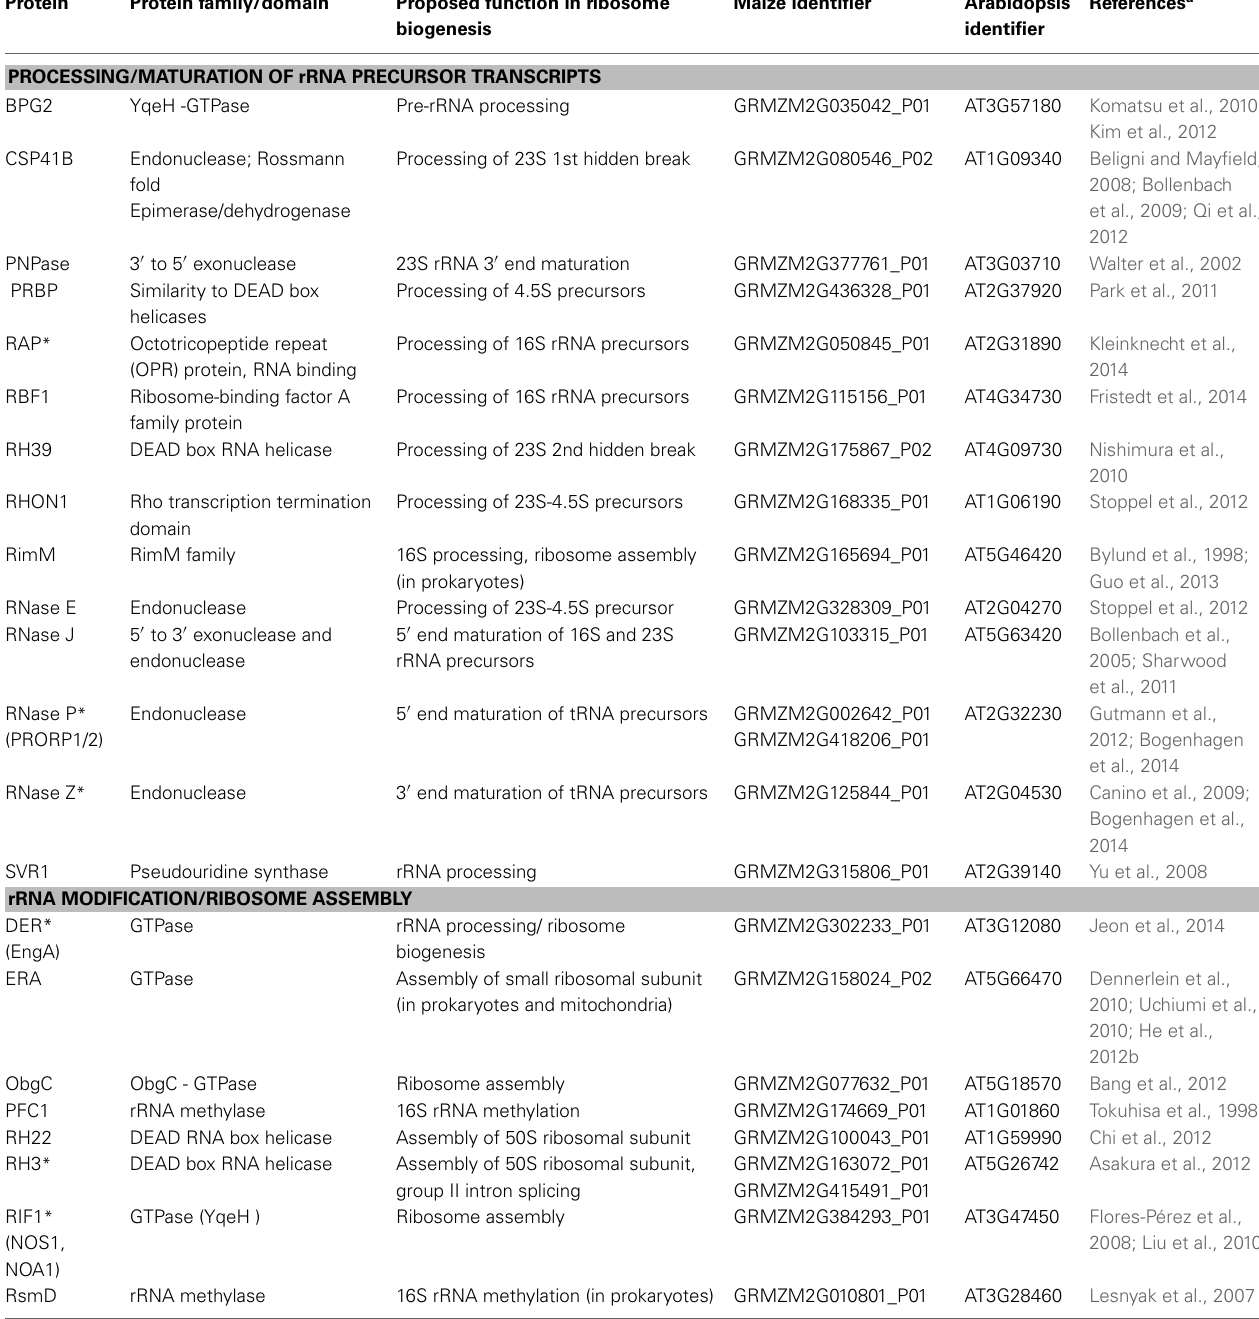
Table 1 | Nucleoid-localized proteins with proposed functions in rRNA processing, maturation and ribosome assembly in plant chloroplasts.